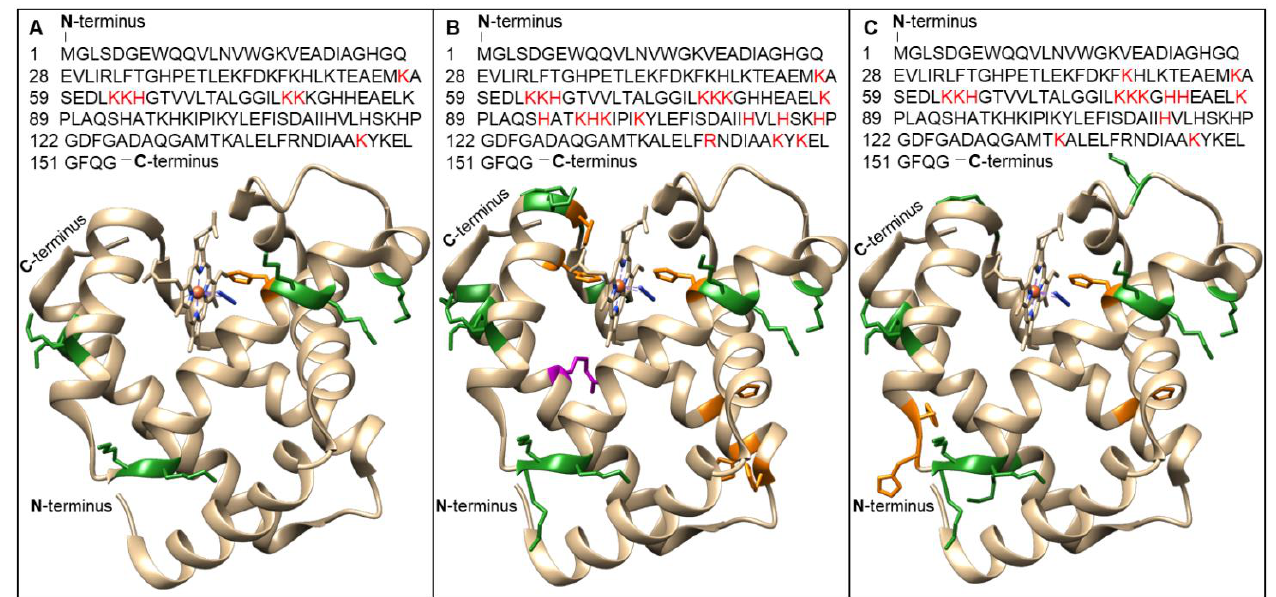
Figure 5. AGEs were identified on a MB protein before ( A ) and after modification with melibiose in dry conditions ( B ) and during aqueous conventional glycation ( C ). One letter sequence with amino acid residues modified with AGEs indicated in red in top panels and a three-dimensional structure model (created in Chimera 1.14 (RBVI)) of MB protein with the marked glycated sites (green — K, orange — H, pink — R residues) are presented in lower panels.